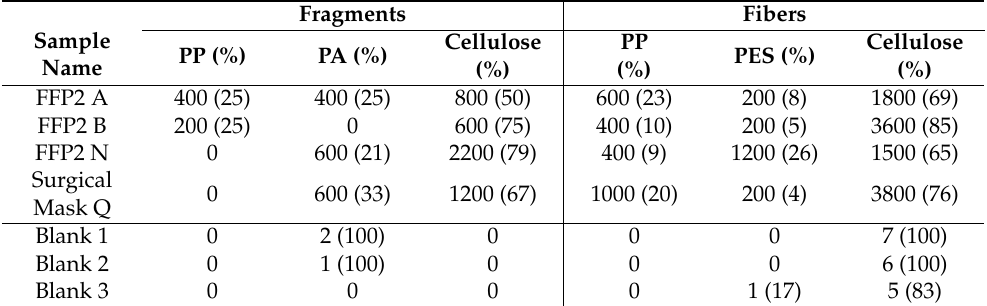
Figure 4. Facial mask Surgical Mask Q studied ( A ); structure after disassembling in layers (500 µ m scale bar) ( B ); and mask spectrum (at the top), spectrum listed in the library (at the bottom) identifying polypropylene, atactic, 96.07% ( C ). Table 3. Concentration of MP fragments and fibers in the face masks migration experiment reported as MP/dm 2 and in number of particles in the blank samples. In parenthesis the percentage of each polymer to ∑ MP (including cellulose) detected in each sample is